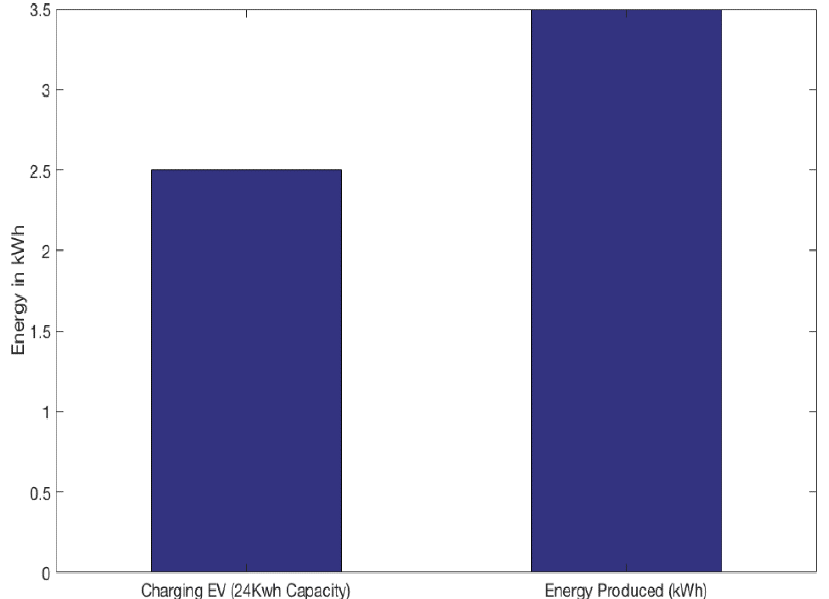
Figure 5. Comparison of the energy produced by a solar PV on a household roof top and the power required to power up a battery. Table 4. ICE vs. BEV.